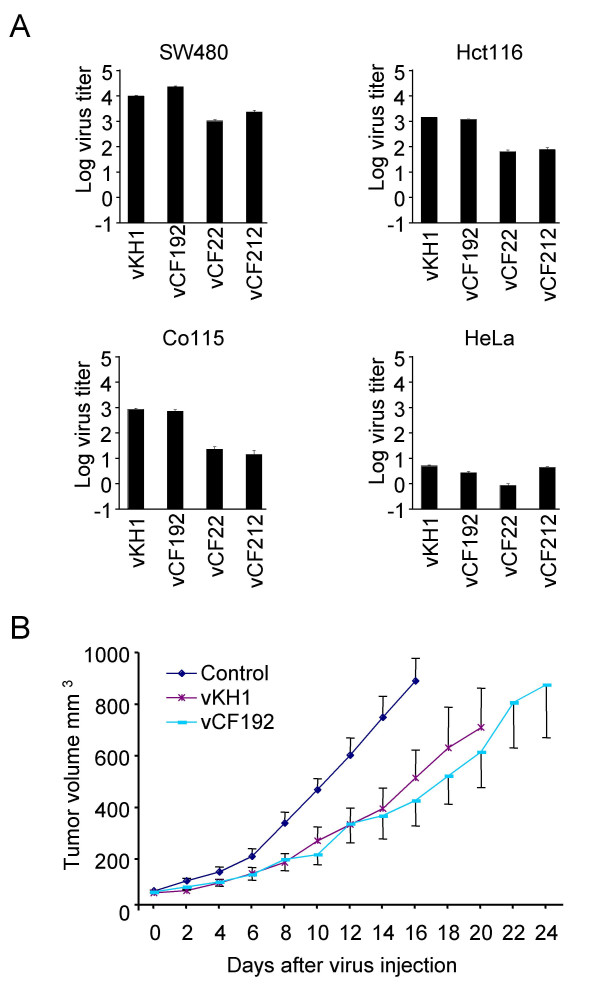
Burst and xenograft assays. A. Burst assays showing that the E1A-HD2 viruses vCF212 (derived from vCF22: Tcf-E1A, E1B, E2, E4) and vCF192 (derived from vKH1: Tcf-E1A, E1B, E4) have similar burst size to the parental viruses in SW480, Hct116 and Co115 colon cancer cells and HeLa cells. Error bars: SEM, n = 3. B. Growth curves of subcutaneous SW620 xenografts in NMRI nu/nu mice. Mice received 1011 particles of vKH1, vCF192 or buffer control i.v. on day 0. Error bars: SEM, n = 6.